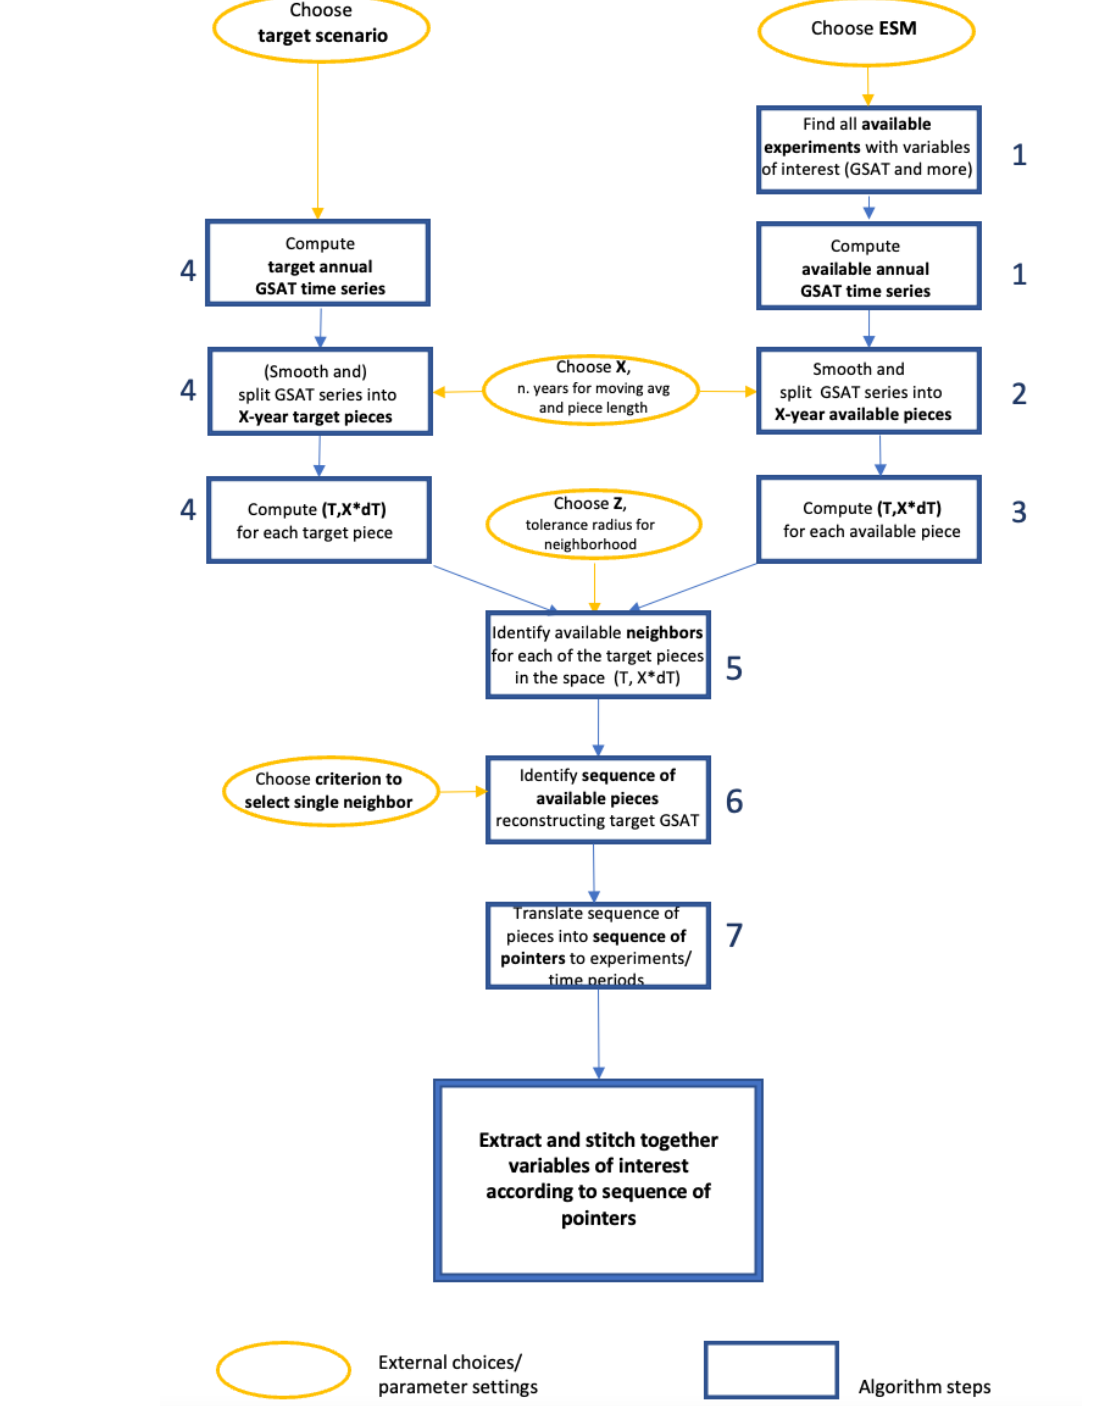
Figure A1. Numbers to the side of the boxes refer to the algorithm steps detailed in Sect. 2.